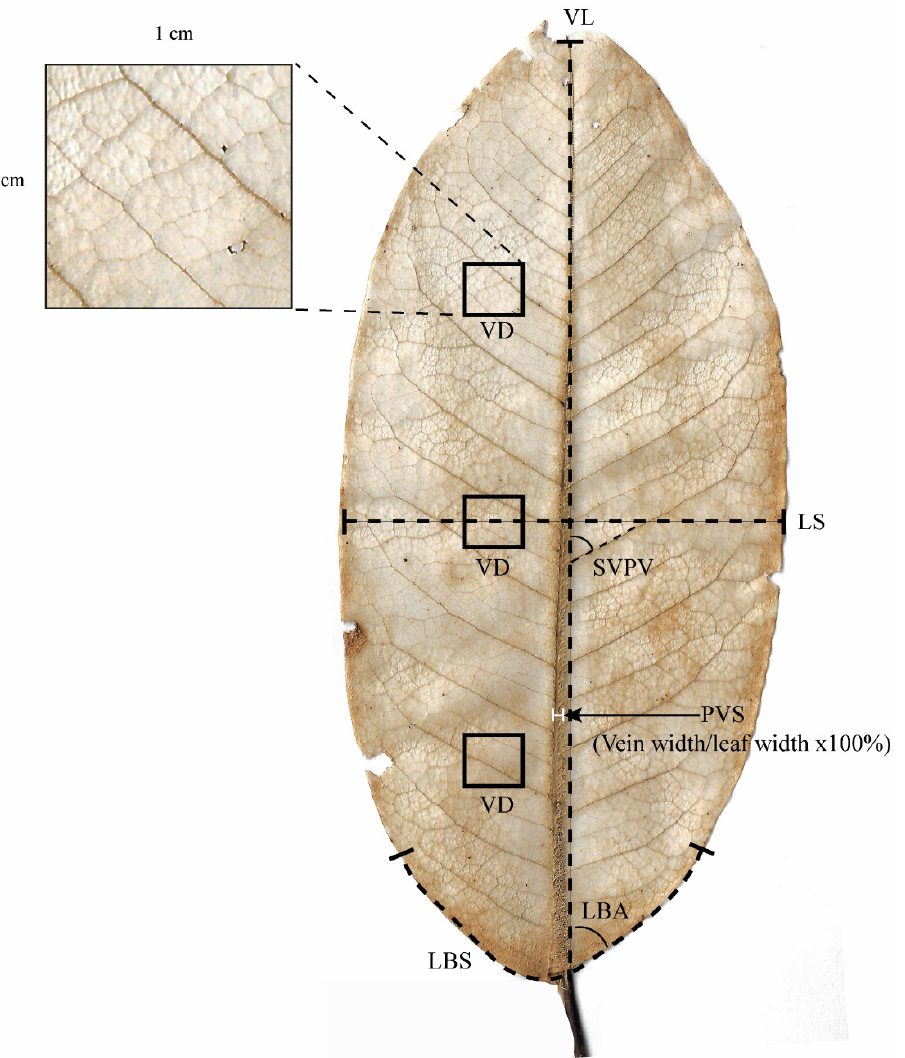
Figure 2. Magnolia schiedeana leaf diagram showing sample vein traits locations. Vein length (VL); Primary vein size (PVS); Leaf base shape (LBS); Leaf base angle (LBA); Angle between major secondary veins and primary veins (SVPV); and Vein density (VD).